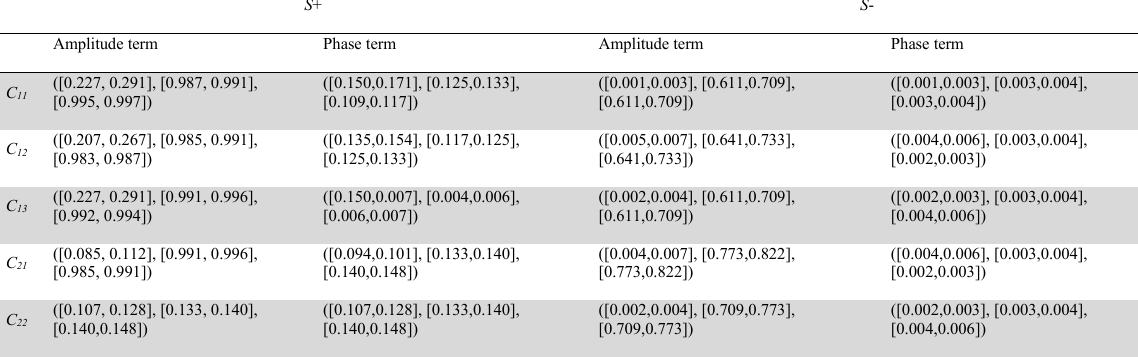
Step 10 : Use the separation measures of each point to PIS and NIS and compare them to select the